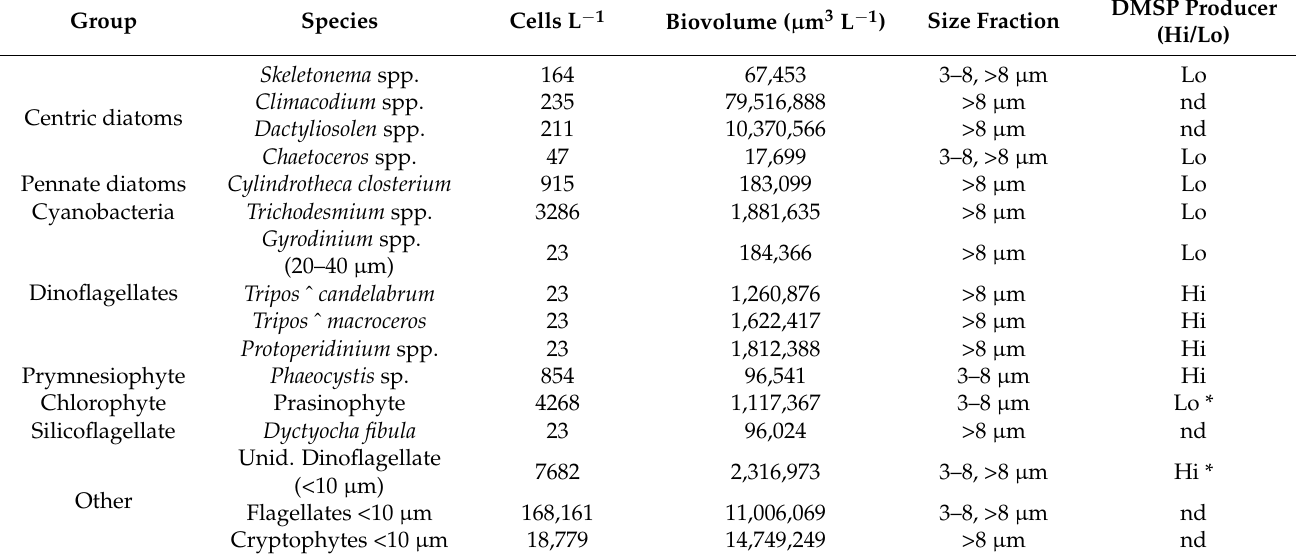
Table 3. Composition of the phytoplankton community, their cell biovolume, fraction, and DMSP production status. Phytoplankton were quantified and identified by IMOS [38]. The smallest fraction (bottom section of table), consisting of mostly flagellates and cryptophytes, were quantified in the picoeukaryote fraction of flow cytometry data. Hi and Lo DMSP-producing classification is taken from McParland et al. [17]. In cases where the species does not match, classification has been matched to genus. nd = no data.